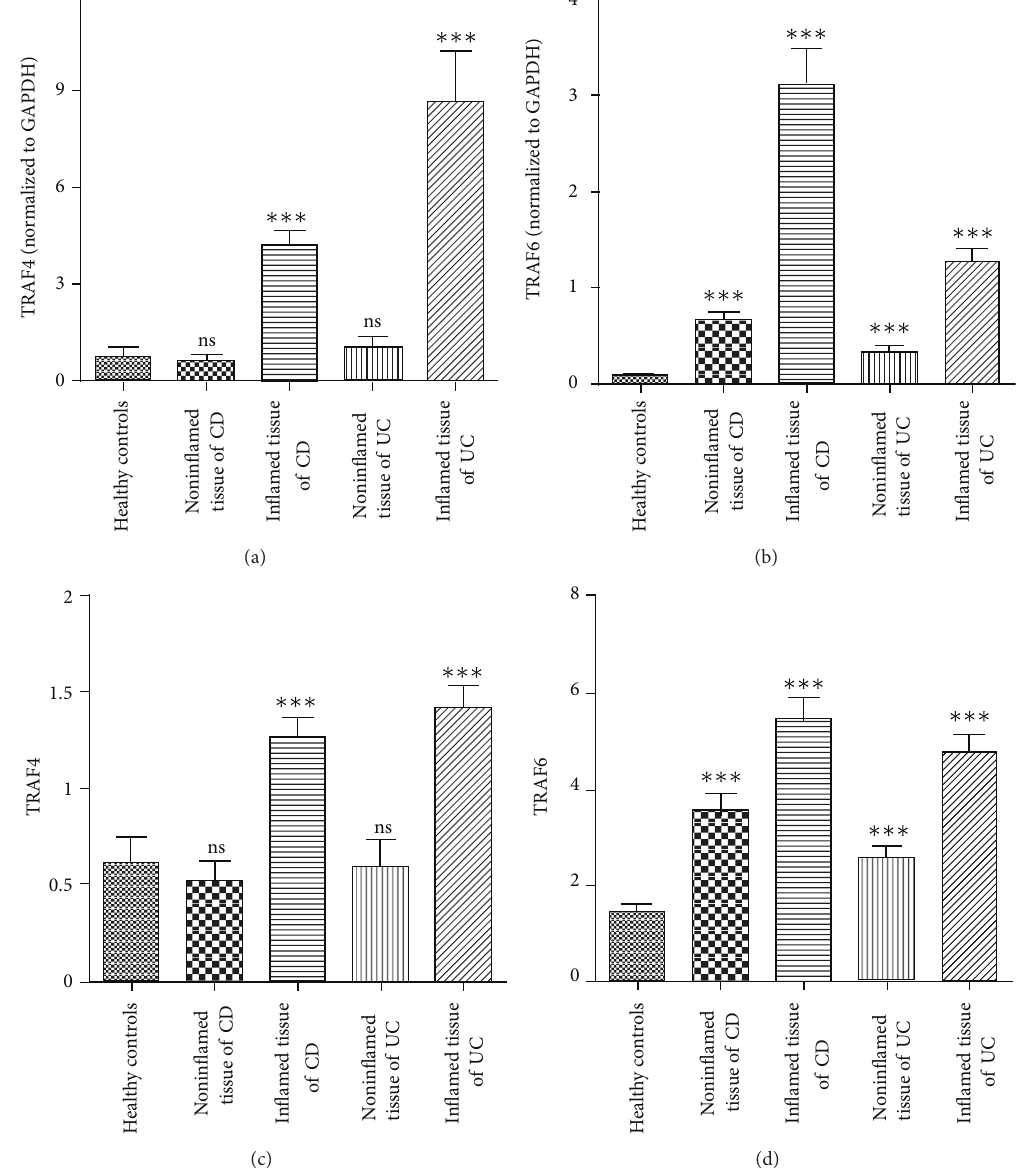
F 3: �ifferences in gene and protein expressions of TRAF4 and TRAF6 in the in�amed and non-in�amed colonic mucosa in patients with Crohn’s disease or ulcerative colitis and in normal control tissues. (a) TRAF4 gene expression; (b) TRAF6 gene expression; (c) TRAF4 protein expression, (d) TRAF6 protein expression. ns: not signi�cant ∗∗∗ 𝑃𝑃 𝑃 𝑃𝑃𝑃𝑃𝑃𝑃